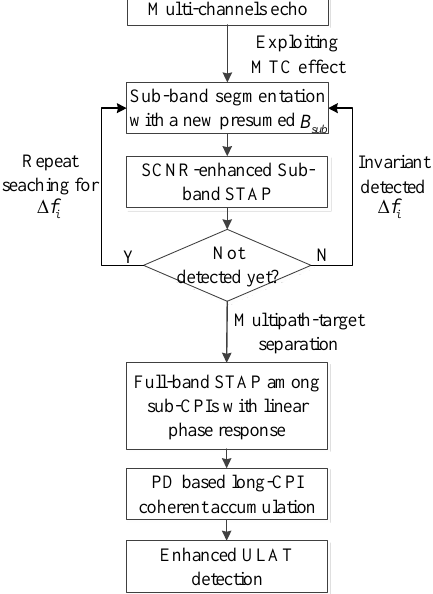
Figure 4. Flowchart of the proposed multi-resolution